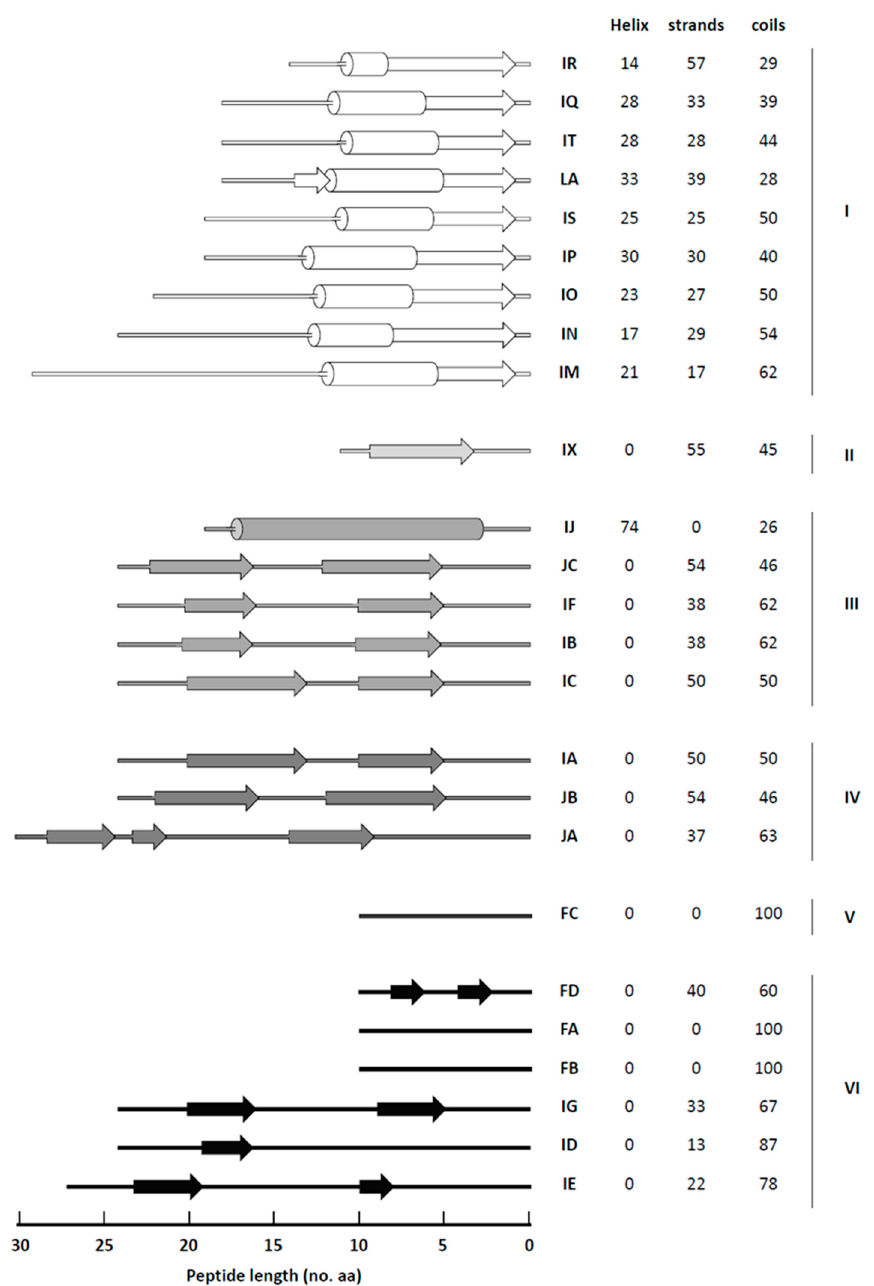
Figure 3. Foreign peptide secondary structures comparison. The chimeric BaMV CP N-terminus secondary structures contents are fused with various foreign peptide regions. Foreign peptide secondary structure assignments are determined by computer prediction with the PSIPRED server algorithm. β -strands are represented by arrows, α -helices are indicated represented by bars, and coil are represented by lines. Numbers represent the mean α -helices, β -strand, and coil in percentage in the foreign peptides, respectively. Chimeric BaMV accumulation in C. quinoa was normalized using BS-d35CP (100%) to account for chimeras; group I: 0%, II: 1–20%, III: 21–40%, IV: 41–60%, V: 61–80%, VI: 81–100%. Group I, II, III, IV, V, and VI are distinguished using white to black shadings. The length of foreign peptides is shown on the bottom.